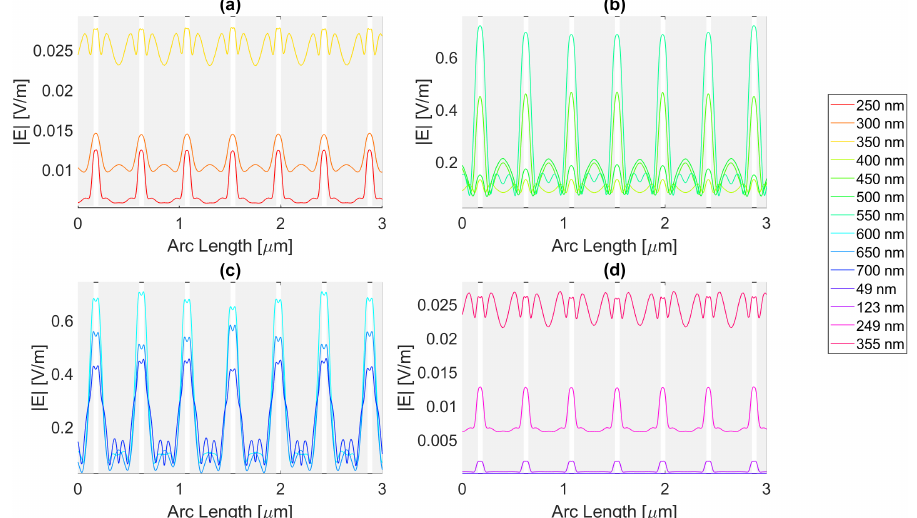
Figure 8. Electric field for silver 50-nm-thick rectangular nanostructure—Probe